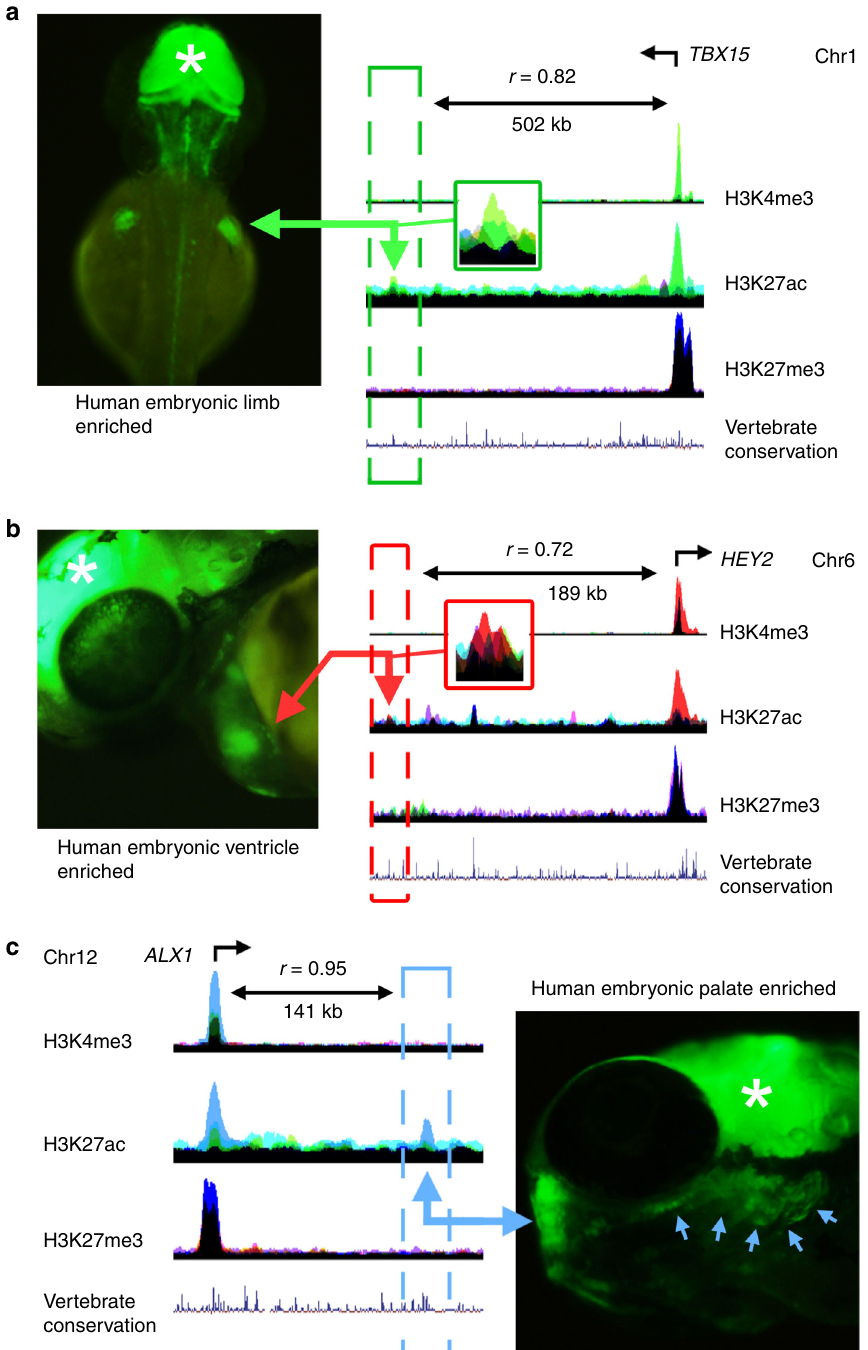
Fig. 4 Transgenic analysis of H3K27ac regions from human embryonic tissues. H3K27ac-marked regions were tested in multiple lines of stable transgenic zebra fi sh (details in Supplementary Data 4; same colour coding of tracks as in Fig. 1). a 231 bp limb enhancer, 502 kb downstream of TBX15 , with the corresponding green fl uorescent protein (GFP) detection in fi n bud at 48 h post fertilisation (hpf). b About 355-bp heart/LV enhancer, 189 kb upstream of HEY2 , with the corresponding ventricular GFP detection at 48 hpf. c 1.5 kb palate enhancer, 141 kb downstream of ALX1 , with GFP in the developing trabecula and mandible (blue arrows) at 48 hpf. Correlations between the enhancer and transcription of the TF gene are shown for each example. Note the H3K27me3 marks over the gene in each instance in other tissues. *, midbrain GFP expression from the integral enhancer in the reporter vector used as a positive control for